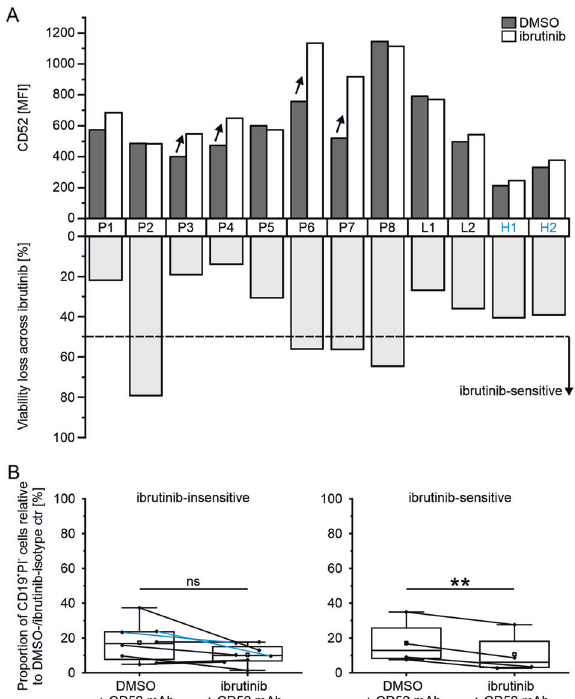
Fig. 4 CD52 as target in ibrutinib-pretreated primary MCL cells. A CD52 levels of primary CD19 + PI − cells from peripheral blood mononuclear cells (PBMCs, P) and lymph nodes (L) from mantle cell lymphoma patients and PBMCs from healthy controls (H, blue) as mean fl uorescence intensity (MFI, median) after 2 – 3 d treatment (patient characteristics in Supplementary Table 2) with ibrutinib (400 nM, DMSO as control), and percentage loss of CD19 + PI − cells after ibrutinib incubation compared with DMSO control (below); data were acquired by fl ow cytometry using CD52-APC, cell debris and doublets were excluded. B Effect of 10 µg/ml CD52 mAb treatment in combination with 10% normal human serum (NHS) on viability of ibrutinib- or DMSO-pretreated primary MCL cells; boxplot (centerline as median and square as mean) shows the percentage of CD19 + PI − cells after treatment with CD52 mAb in ibrutinib- insensitive (viability loss by ibrutinib < 50%, left) and ibrutinib- sensitive (viability loss by ibrutinib > 50%, right) cases relative to control treatment with isotype control of the corresponding pretreatment (ctr); Shapiro-Wilk test was performed to test the data for normal distribution and signi fi cance was determined by Paired t - test, ** P < 0.01, P > 0.05 not signi fi cant differences in OCR/ECAR ratios between ibrutinib-sensitive and resistant MCL cell lines were not con fi rmed by our results, showing similar ratios for ibrutinib-sensitive REC-1 and resistant MAVER-1, which may be due to different culture conditions, cell density, and experimental setup in general [19, 46, 47]. In view of the impairment of glycolytic capacity by ibrutinib and the triggering of OXPHOS dependence in surviving MCL cells, the OXPHOS inhibitor IACS- 010759 was added to ibrutinib-pretreated cells to block the metabolic escape [7, 18]. Surprisingly, the sequential combination did not reduce proliferation and viability of the tumor cells compared to ibrutinib alone, as cells likely compensated quenched OXPHOS by restoring glycolysis [48]. In contrast, simultaneous ibrutinib treatment plus OXPHOS inhibition increased toxicity. However, for in vivo use, an acceptable side effect pro fi le must be ensured with respect to the proliferation already heavily reduced by the single agents. Consider- ing the interplay between growth stimulating signaling pathways such as BTK signaling and bioenergetic processes in malignant B cells, combination regimens have to be carefully evaluated to avoid cross-reducing effects and thus maximize their ef fi cacy [49]. Patients may also pro fi t from IACS-010759 as a single agent, since its